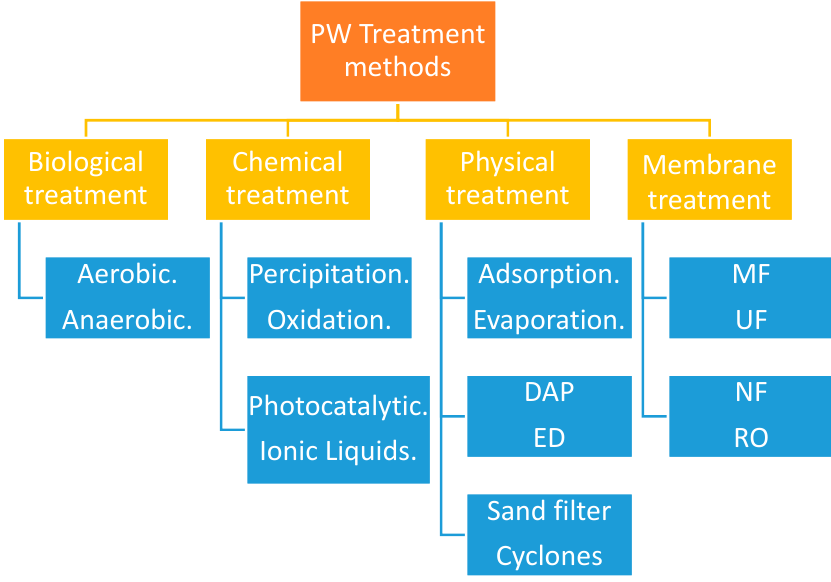
Figure 1. PW treatment methods.